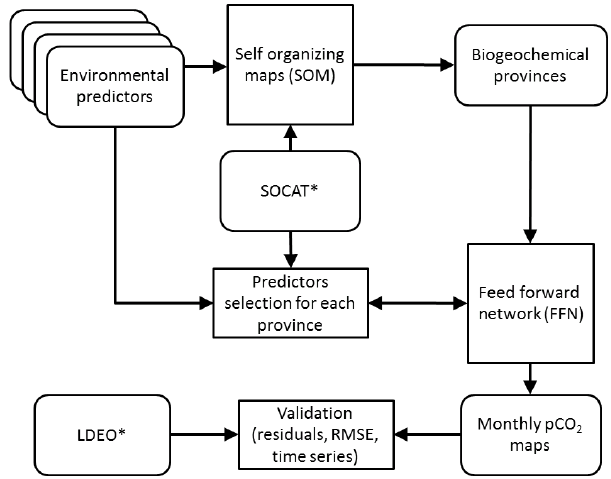
Figure 1. Schematic scheme of the different steps involved in the SOM-FFN artificial neural network calculations leading to continu- ous monthly p CO 2 maps over the 1998–2015